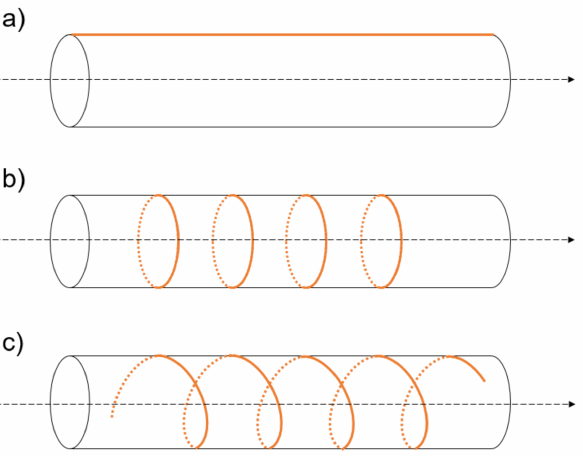
Figure 3. Three main sensor geometry types: ( a ) axial, ( b ) loop or hoop and ( c ) helical. Orange curves denote fibre-optic